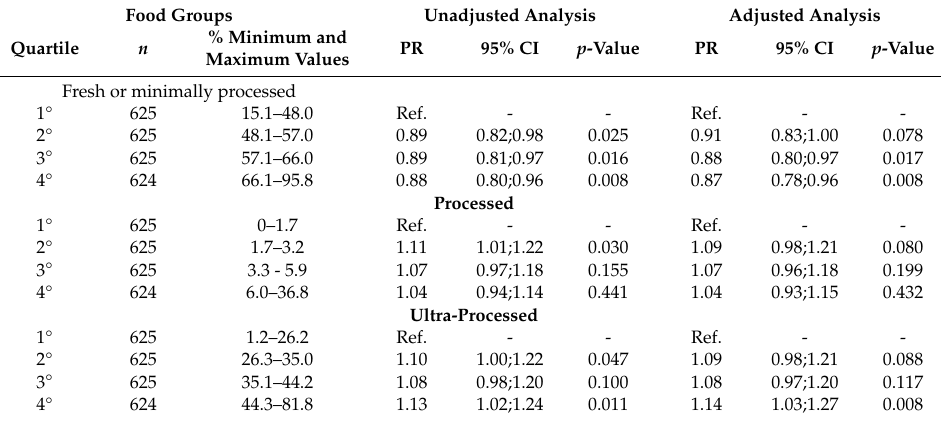
Table 4. Association between consumption of minimally processed, processed, and ultra-processed foods and sleep quality in adolescents from S ã o Lu í s, Maranh ã o, Brazil,